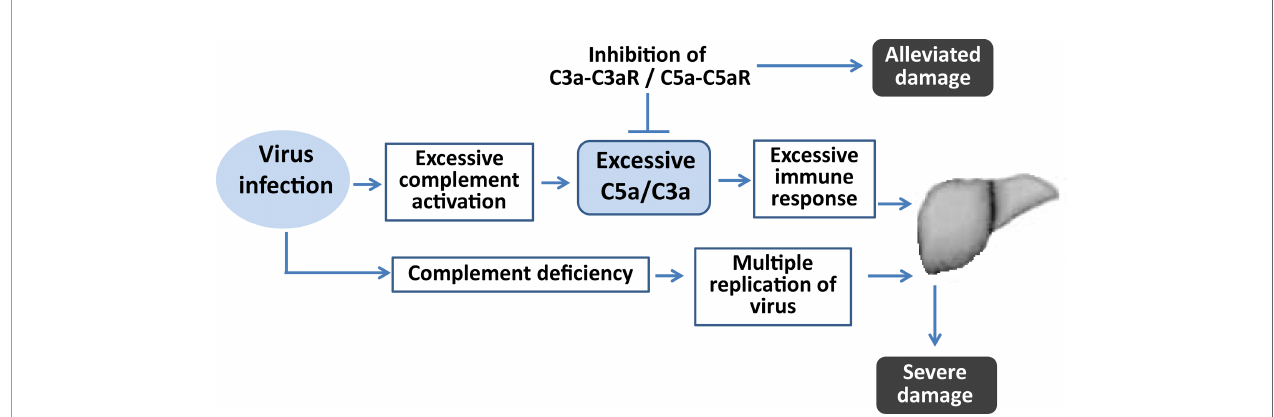
FIGURE 6 | Diagram illustrating the role of complement in virus-induced fulminant hepatic failure. Complement de fi ciency contributes to more severe liver damage because of uncontrollable viral replication. Sustained complement activation after virus infection contributes to excessive in fl ammatory responses. Regulation of the complement by inhibition of its activation could alleviate liver damage by regulating the imbalanced in fl ammatory